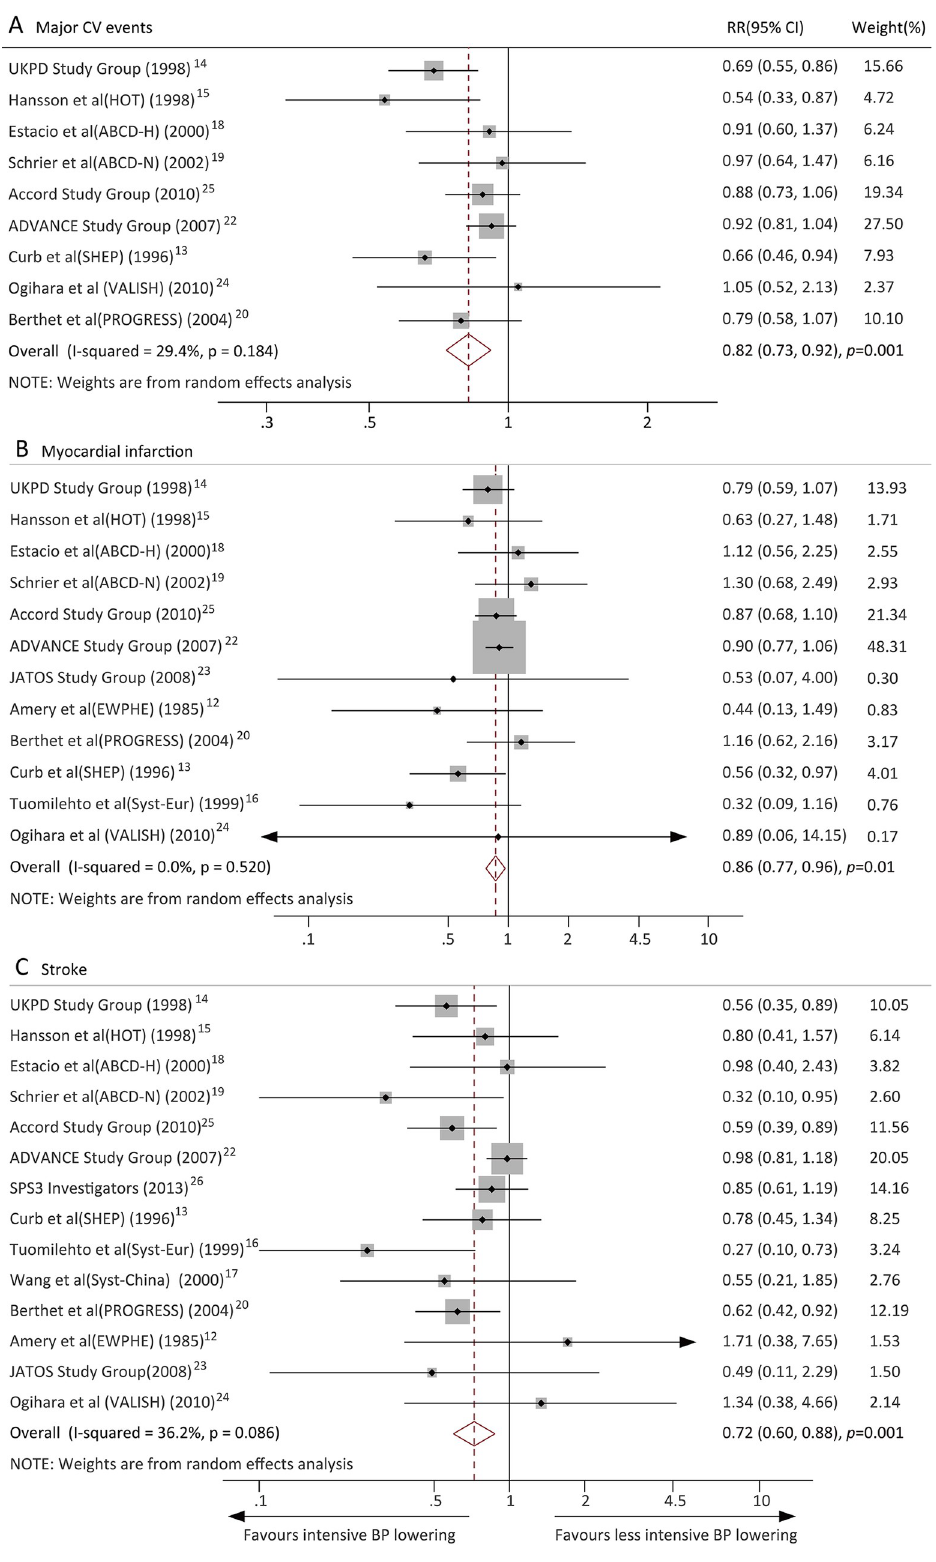
Fig 3. Effects of intensive blood pressure lowering on risk of cardiovascular outcomes (A) Major cardiovascular events; (B) Myocardial infarction; (C) Stroke. https://doi.org/10.1371/journal.pone.0215362.g003 PLOS ONE | https://doi.org/10.1371/journal.pone.0215362 April 12,